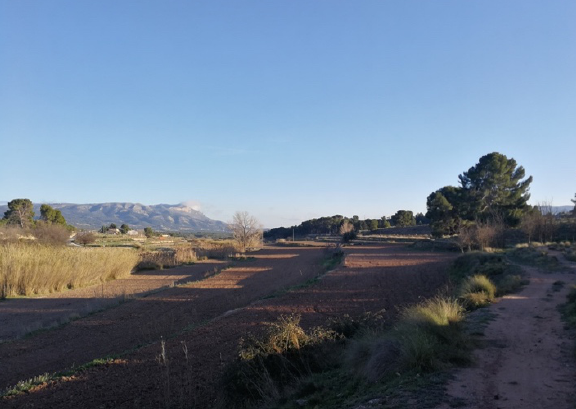
Figure 12. Current view of Casa de la